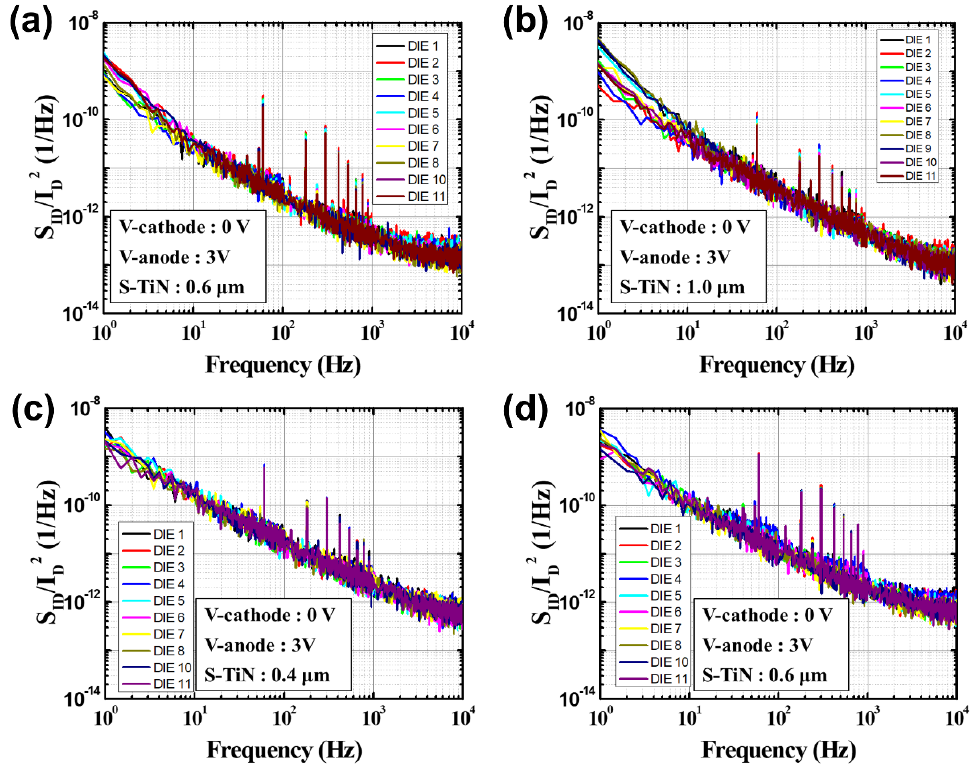
7 of 13 Table 2. Comparison of values at the midpoint (50%) of the cumulative curves plotted in Figure 6 of the four types of a-Si microbolometers. P35-S06 − 2.63 The noise characteristics of the devices with the pixel pitch of 35 μm or 12 μm de-